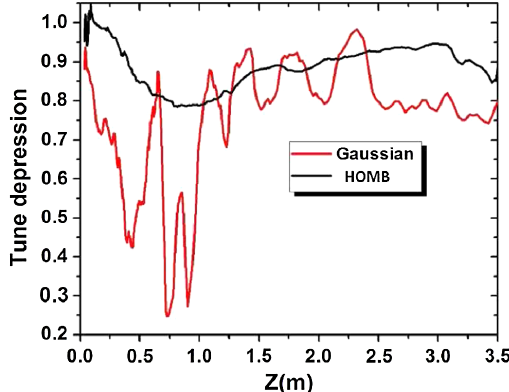
FIG. 8. Tune depression for the Gaussian and HOMB along the